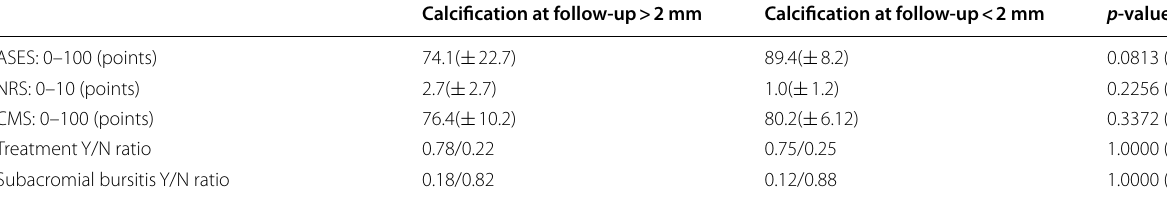
Data are expressed as mean (